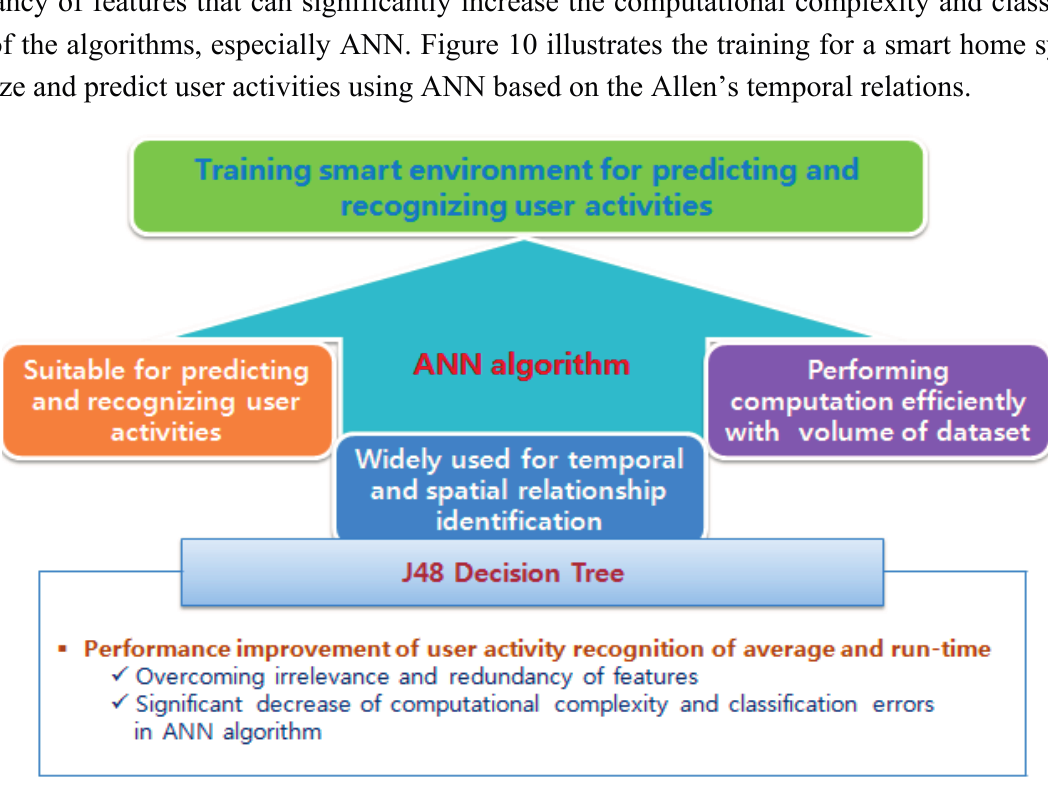
Figure 10. Training smart environment for activities